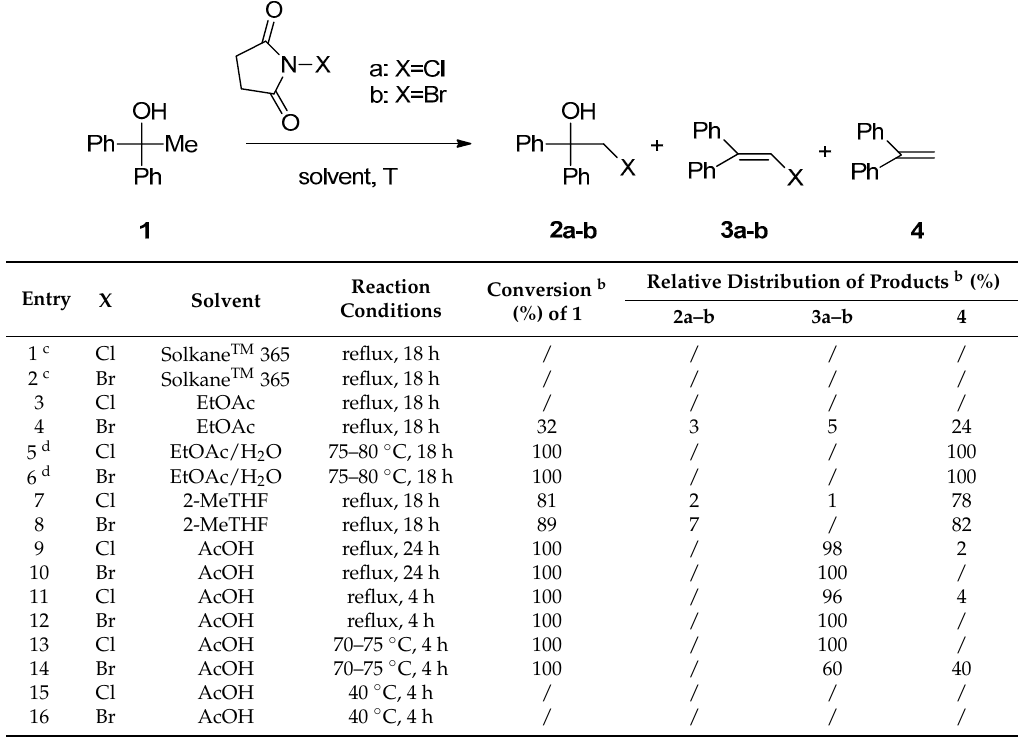
Table 1. Transformation of 1,1-diphenylethanol 1 with N -chlorosuccinimide (NCS) and N -bromosuccinimide (NBS) in organic solvents a .